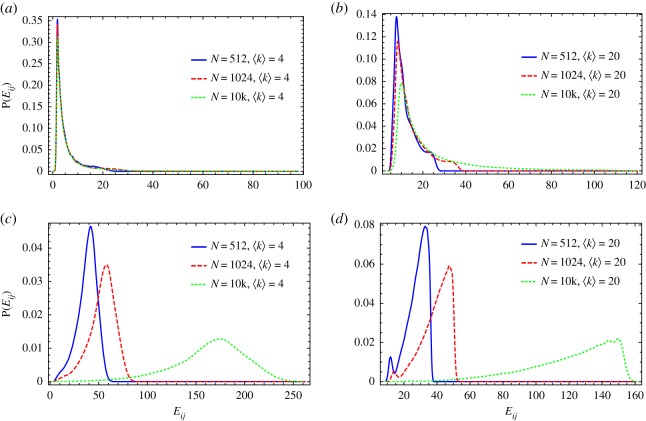
Distributions of the GENs for the Barabási–Albert networks for nodes that do share a direct connection (a,b) and do not share a connection (c,d) for 〈k〉 = 4 (a,c) and 〈k〉 = 20 (b,d) and with N = 512 (blue solid lines), 1024 (red dashed lines) or 104 (green dotted lines). The behaviour is consistent with the ER networks in figure 6: the mean values depend strongly on 〈k〉 and weakly on N if the nodes share a direct connection, while the opposite is true if the nodes are not neighbours. Because the heavy tail of the degree distribution (with P(k) ∝ k−3) provides a broader distribution to the connected GENs distribution than in the ER case (figure 6), the mean values are further from the peaks of the distribution and are not indicated in the figure.